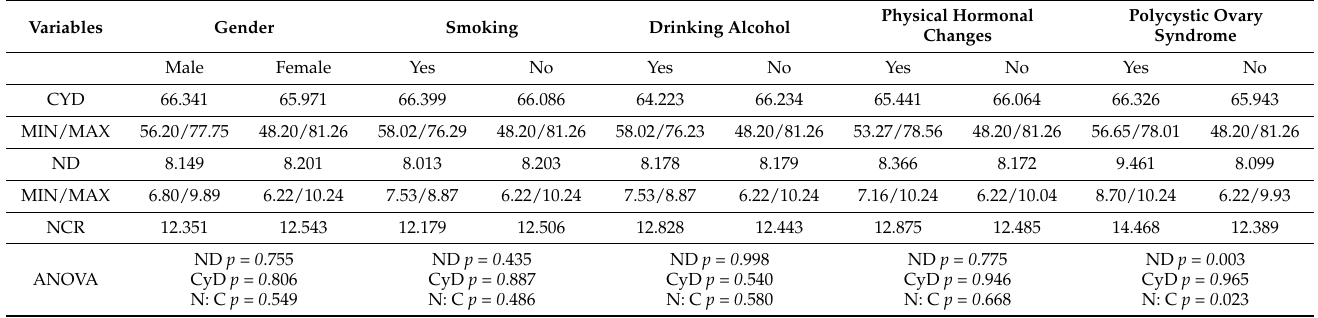
Table 4. The relation of sex, habits, and hormonal changes to cytoplasmic, nuclear diameters, and nuclear/cytoplasmic